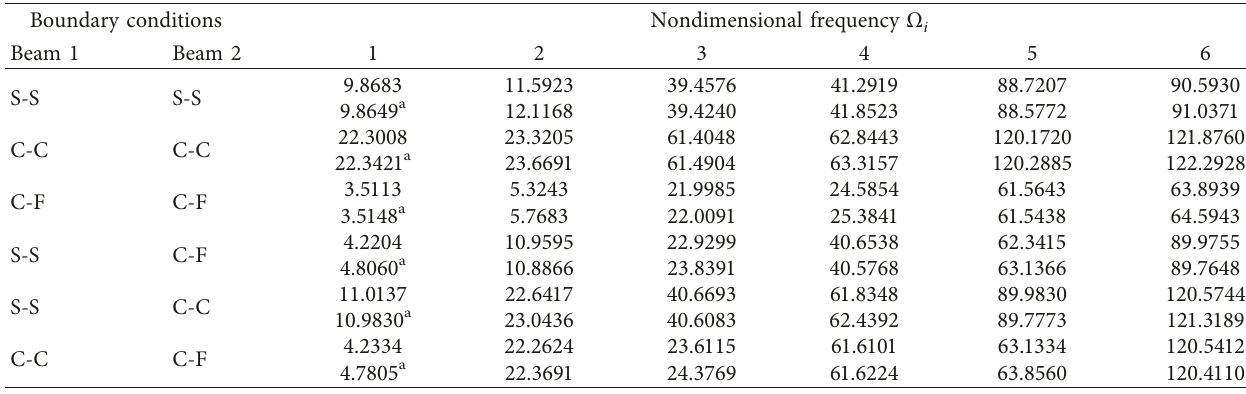
Table 2: The first six nondimensional frequency Ω for the uniform double-beams with different boundary conditions ( k � 1 × 105 N / m 2 ). K c